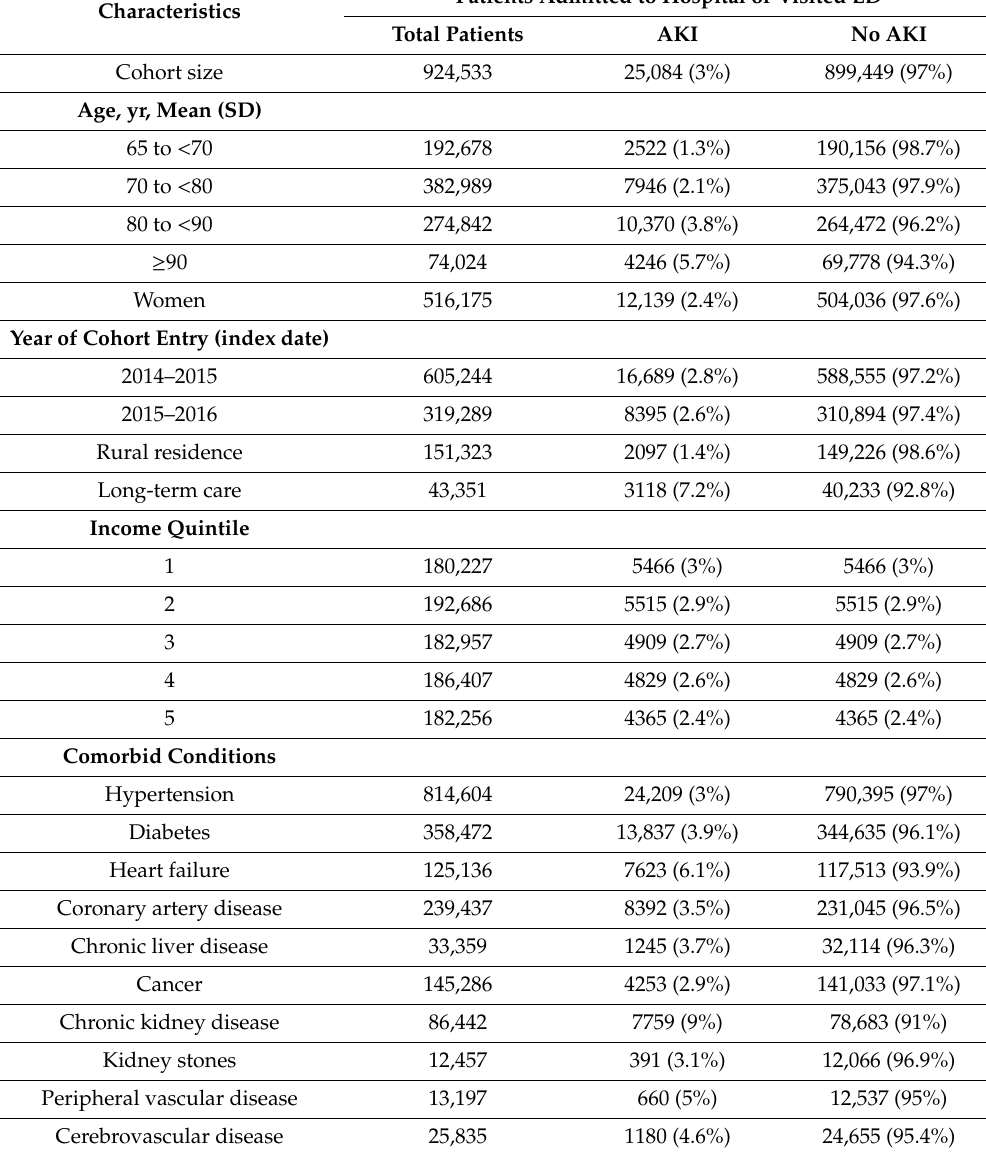
Table 1. Baseline characteristics of patients admitted to the hospital or who visited the emergency department